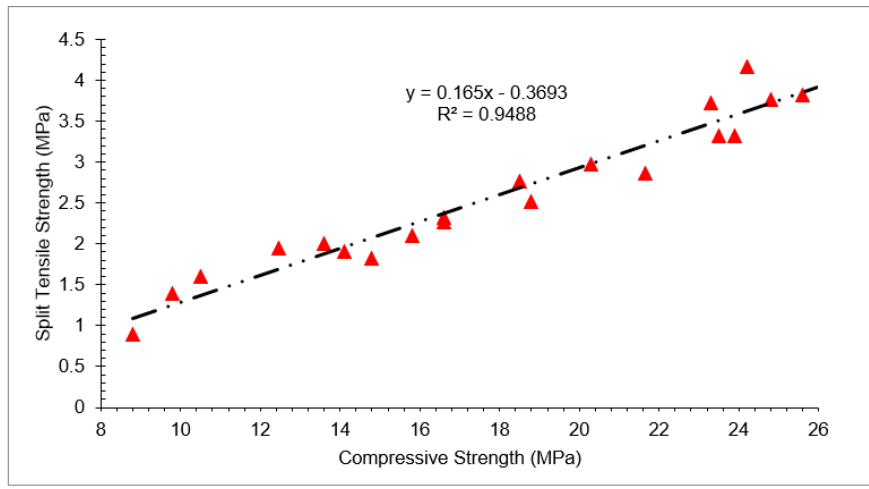
Figure 13. Correlation between compressive and split tensile strength (7, 28 and 56 days).